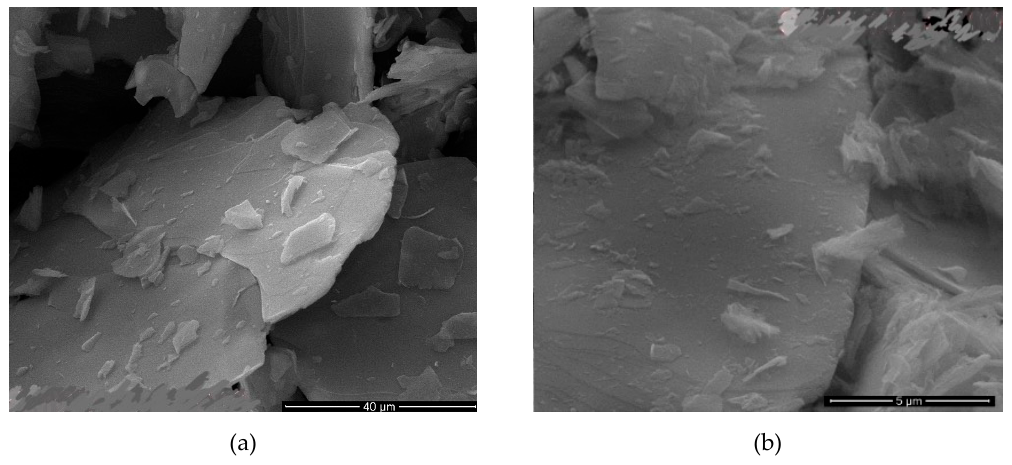
Figure 11. SEM images of the M x2c3 sample with a sonication time of 12 h with higher magnification ( a ) 500×; ( b ) 1000×. Minerals 2020 , 10 , 572